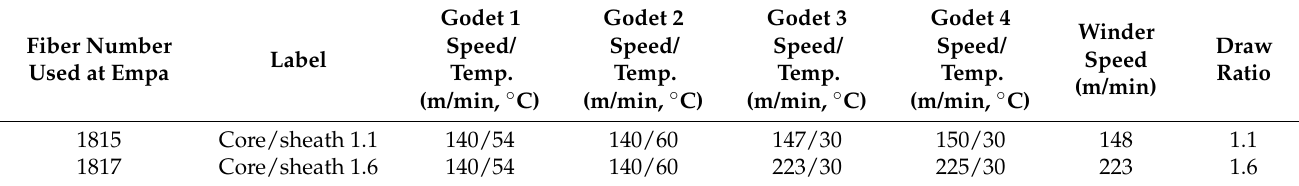
Table 1. Production parameters of core/sheath PL-POFs.